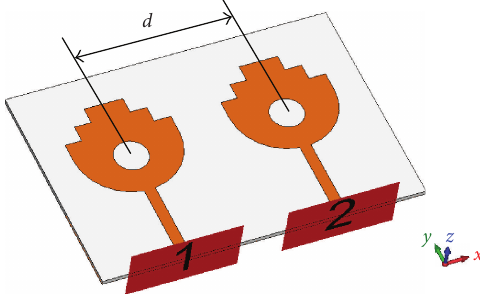
Figure 3: Two identical UWB antenna elements fed simultaneously through two independent microstrip lines.